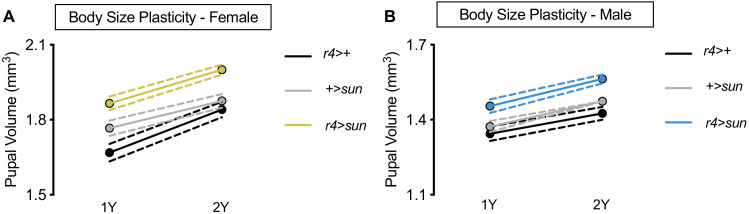
stunted (sun) overexpression augments body size but does not confer increased body size plasticity in males.(A) Pupal volume was significantly higher in r4>+, +>UAS-sun, and r4>UAS-sun females reared on a protein-rich diet (2Y) compared with genotype-matched females cultured on a diet containing half the protein concentration (1Y) (p<0.0001 for all genotypes; two-way ANOVA followed by Tukey HSD test). The magnitude of the nutrient-dependent increase in pupal volume was not significantly different between female genotypes (genotype:diet interaction p=0.0895; two-way ANOVA followed by Tukey HSD test). n = 43–65 pupae. (B) Pupal volume was significantly higher in r4>+, +>UAS-sun, and r4>UAS-sun males reared on 2Y compared with genotype-matched males cultured on 1Y (p<0.0001 for all genotypes; two-way ANOVA followed by Tukey HSD test), but the magnitude of the nutrient-dependent increase in pupal volume was not different between male genotypes (genotype:diet interaction p=0.4959; two-way ANOVA followed by Tukey HSD test). n = 44–67 pupae. For body size plasticity graphs, filled circles indicate mean pupal volume, and dashed lines indicate 95% confidence interval.